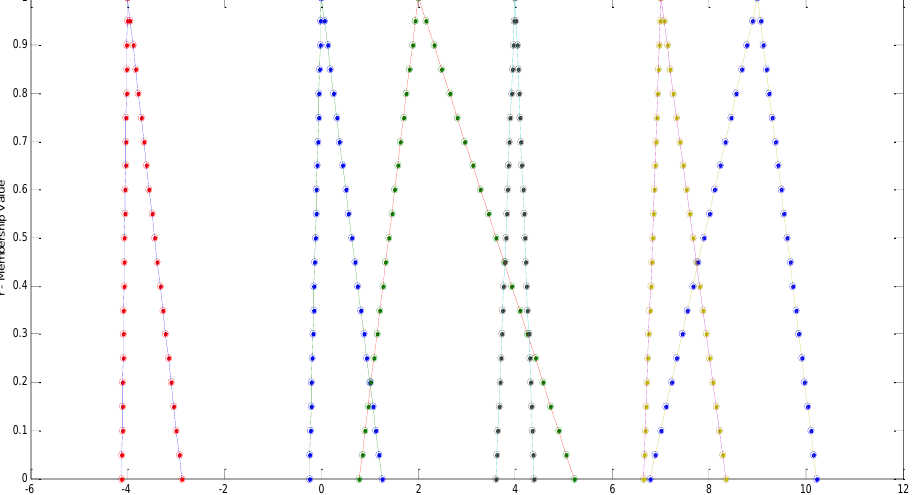
Figure 1. The Hausdorff distance of solutions with 𝜀 = 10 −3 , in the Jacobi method is 0.4091 × 10 −3 . Mathematics 2018 , 6 , x